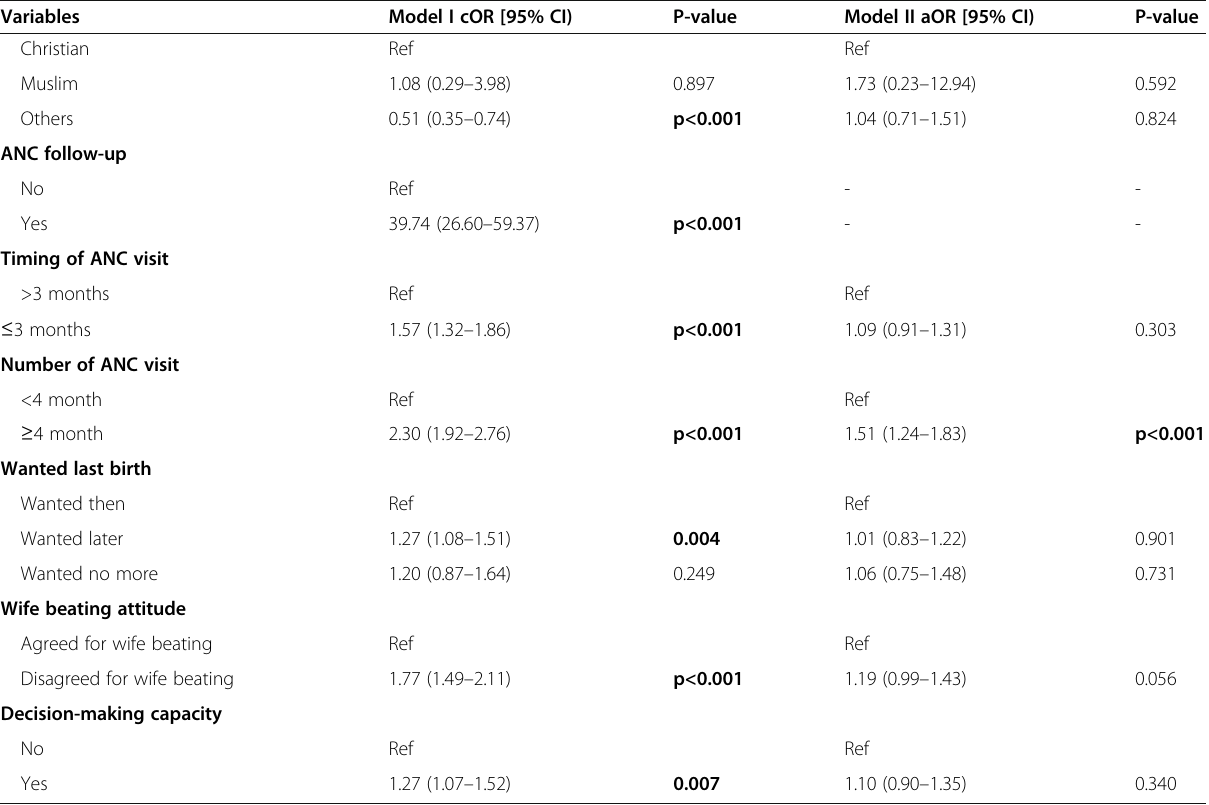
Table 4 Bivariate and multivariable logistic regression output for factors associated with utilization of deworming medication among married women: evidence from 26 SSA countries DHSs